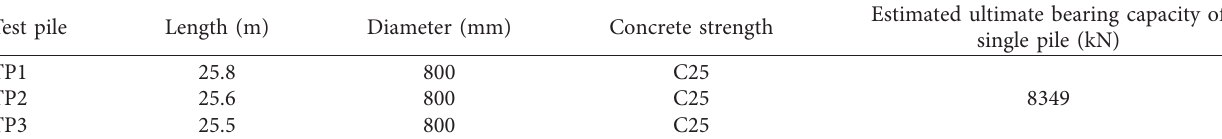
Table 1: Parameters of test piles.